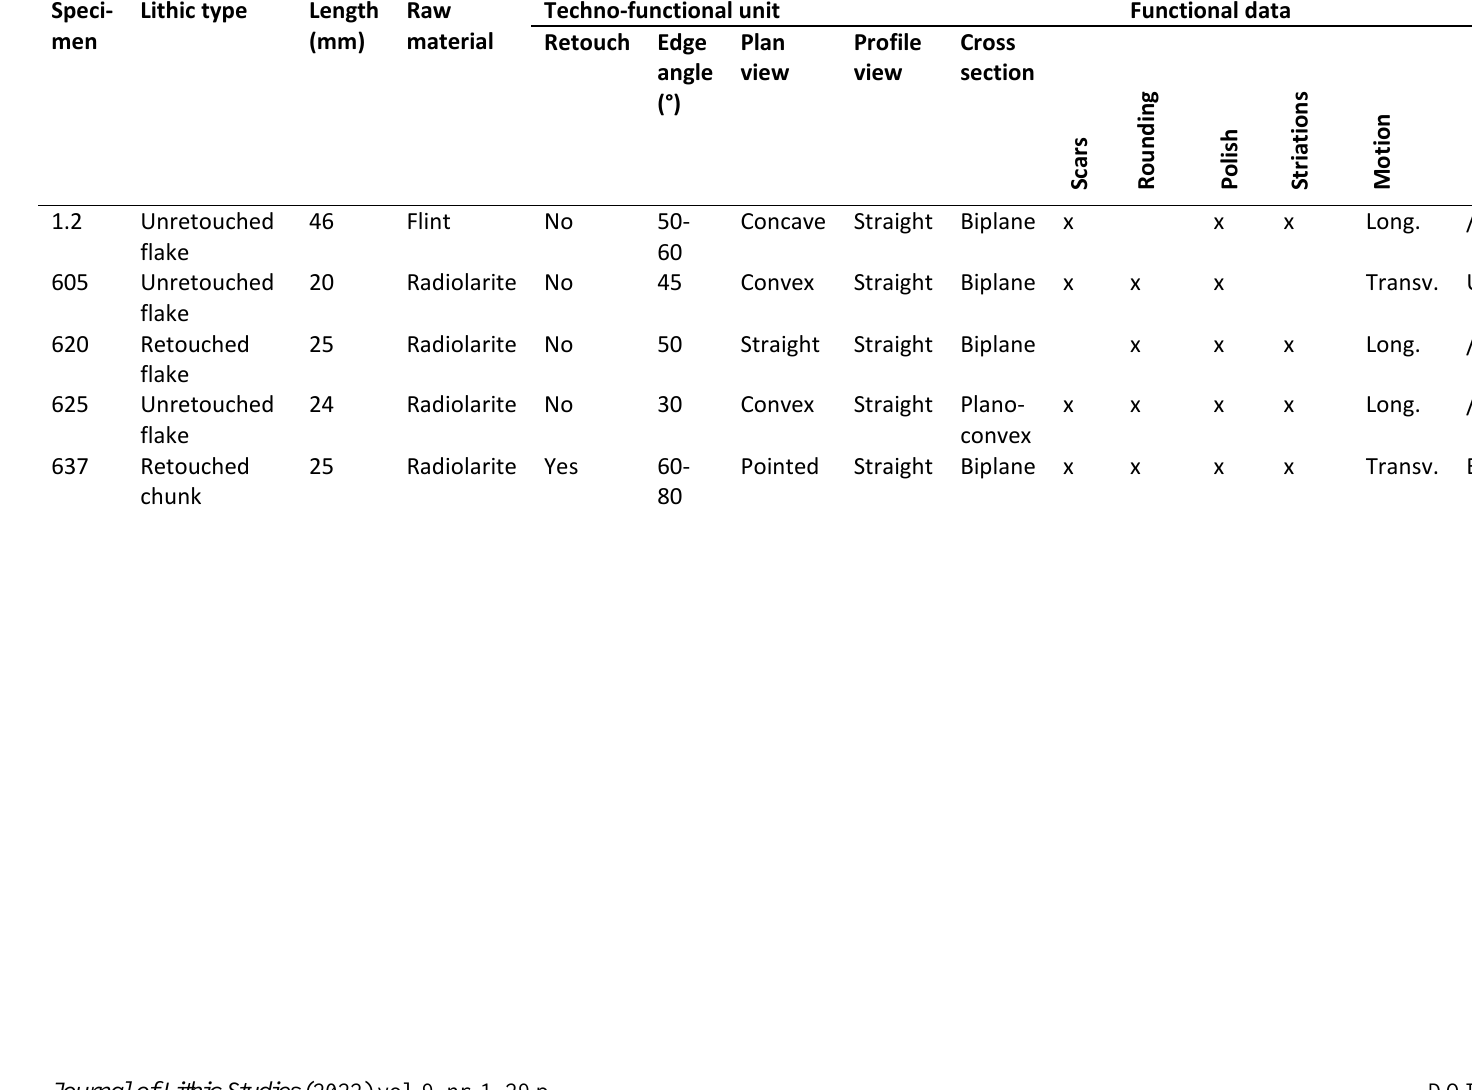
Table 4. Summary of pieces from MAR-1 with use-wear traces. Abbreviations: Long. - longitudinal; Transv. - transversal; Unidir. - unidirectional; Bidir. -